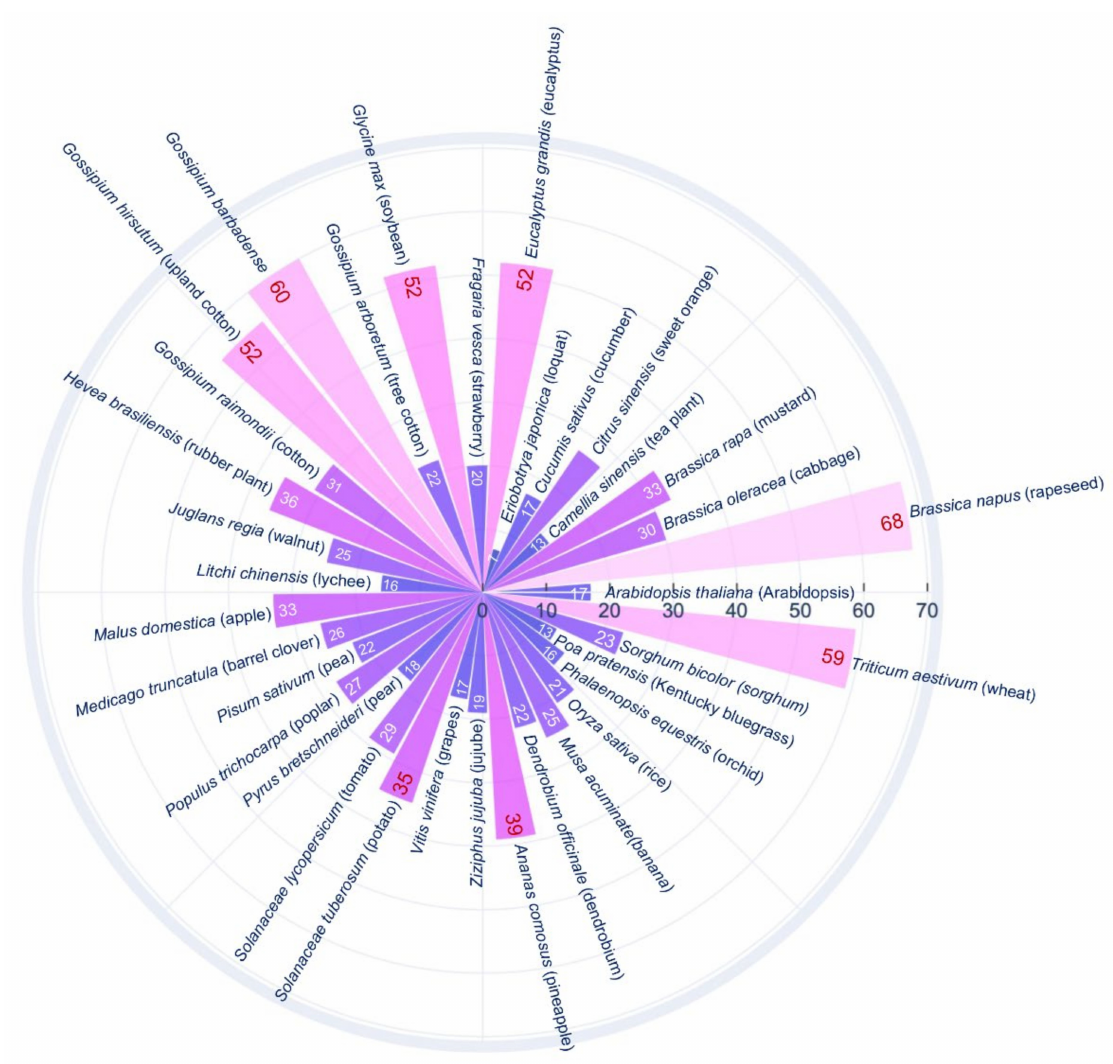
Figure 3. Bar plot showing the SWEET genes present in different plant species. Arabidopsis thaliana [19], Brassica napus [63], Brassica oleracea [64], Brassica rapa [65,66], Camellia sinensis [44], Citrus sinensis [67,68], Cucumis sativus [69], Eriobotrya japonica [70], Eucalyptus grandis [71], Fragaria vesca [72], Glycine max [62], Gossypium arboretum [73], Gossypium barbadense [73], Gossypium hirsu- tum [73,74], Gossypium raimondii [73], Hevea brasiliensis [75], Juglans regia [76], Litchi chinensis [77], Malus domestica [78], Medicago truncatula [79,80], Pisum sativum [79], Populus trichocarpa [81], Pyrus bretschneideri [82], Solanaceae lycopersicum [83], Solanaceae tuberosum [84], Vitis vinifera [85], Ziziphus jujuba [86], Ananas comosus [87], Dendrobium officinale [88], Musa acuminate [43], Oryza sativa [89], Phalaenopsis equestris [88], Poa pratensis [90], Sorghum bicolor [91], Triticum aestivum [92,93]. The number depicted on the bar graphs represent number of SWEET genes in the plant